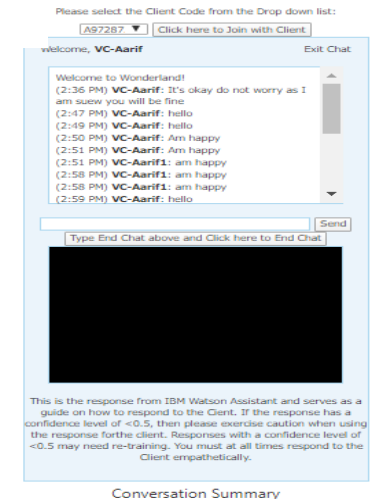
Figure 14. The Counsellor’s screen